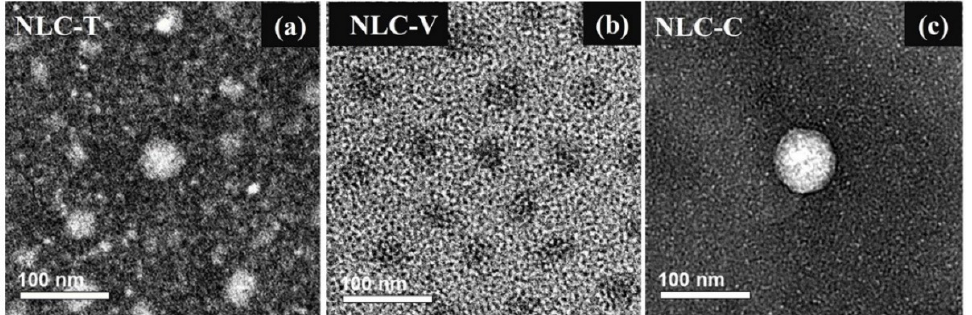
Figure 3. TEM images of NLC-T ( a ), NLC-V ( b ), and NLC-C ( c ). The bars are 100 nm.